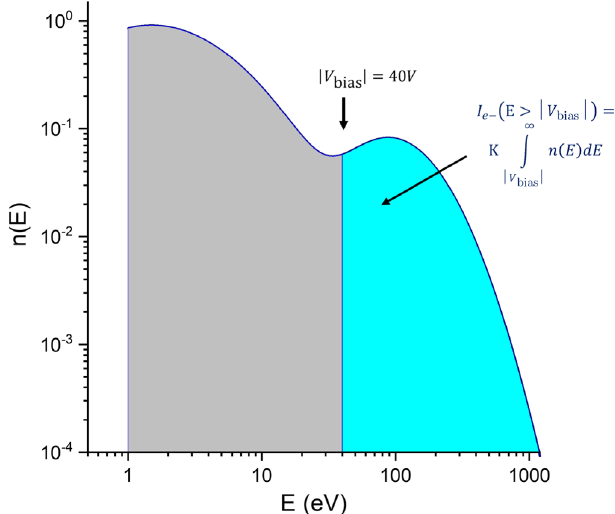
FIG. 10. Normalized energy spectrum of electrons n ð E Þ as a function of energy. The blue part corresponds to the contribution of electrons to the intensity recorded by an electrode polarized at V bias